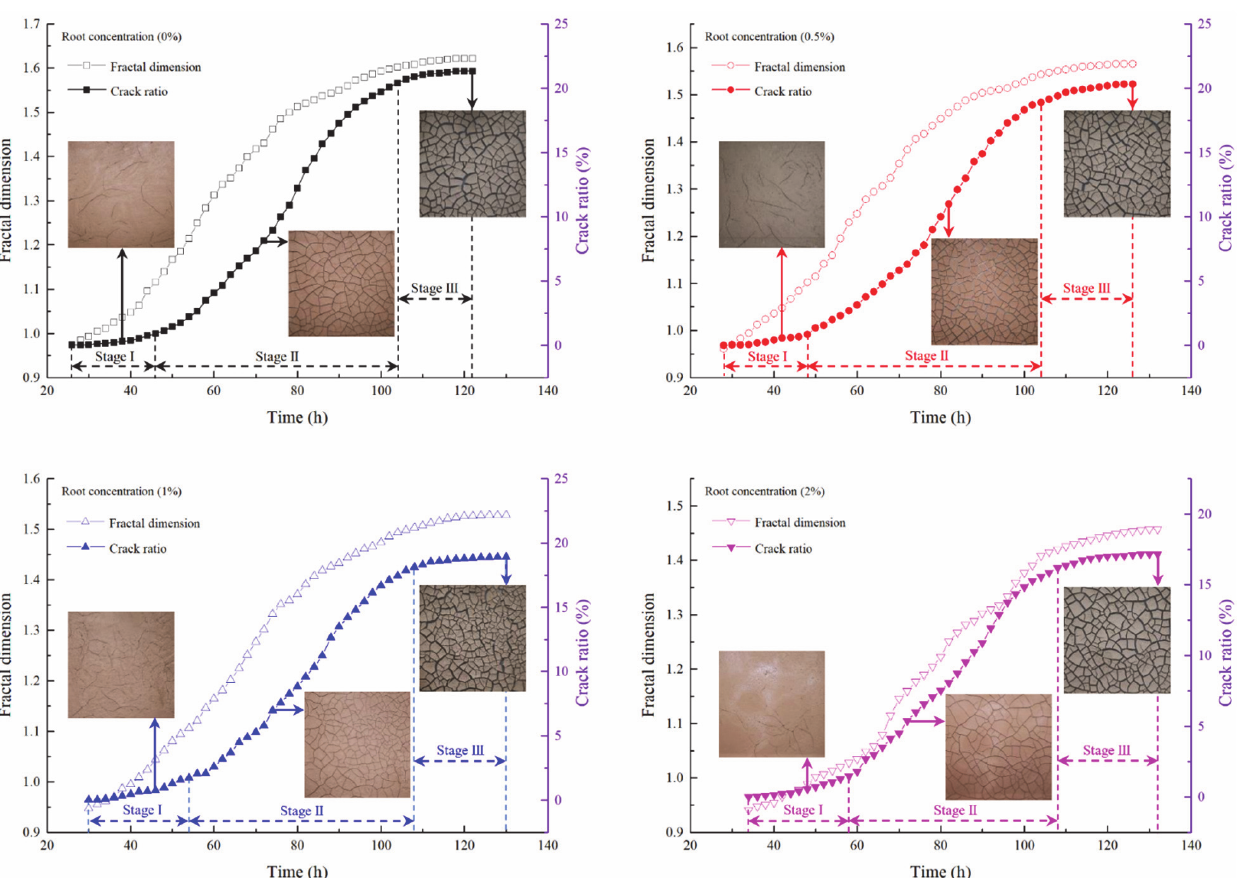
Figure 5. The relationship between fractal dimension and crack ratio with time of saline − alkali soil samples.